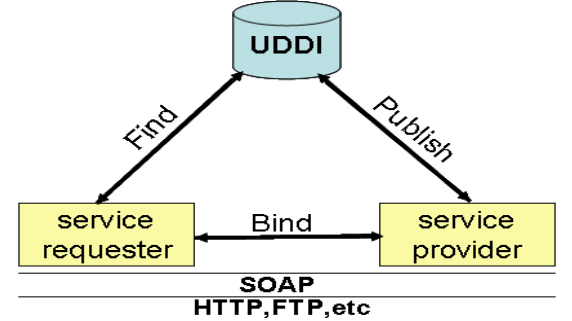
Figure 1. Deployment, research and invocation of web service